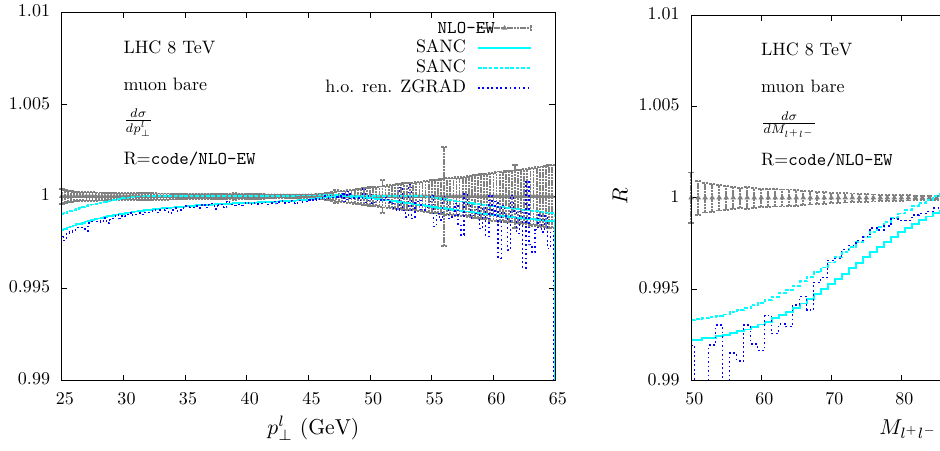
Fig. 28 Relative effects of higher-order ( O ( G 2 μ ) and higher) EW cor- rections in pp → γ, Z → μ + μ − , due to the inclusion of universal corrections using the ρ parameter as described in the text. Shown are the lepton transverse momentum ( left ) and lepton-pair invariant mass